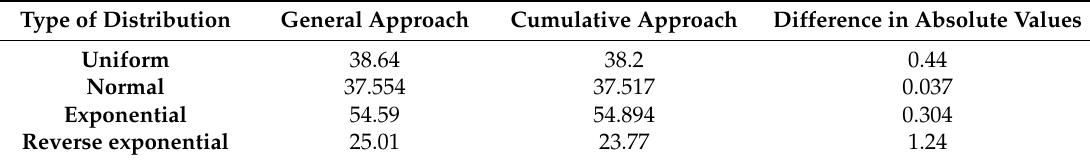
Table 6. Comparison of estimated total number of PC trips per year.